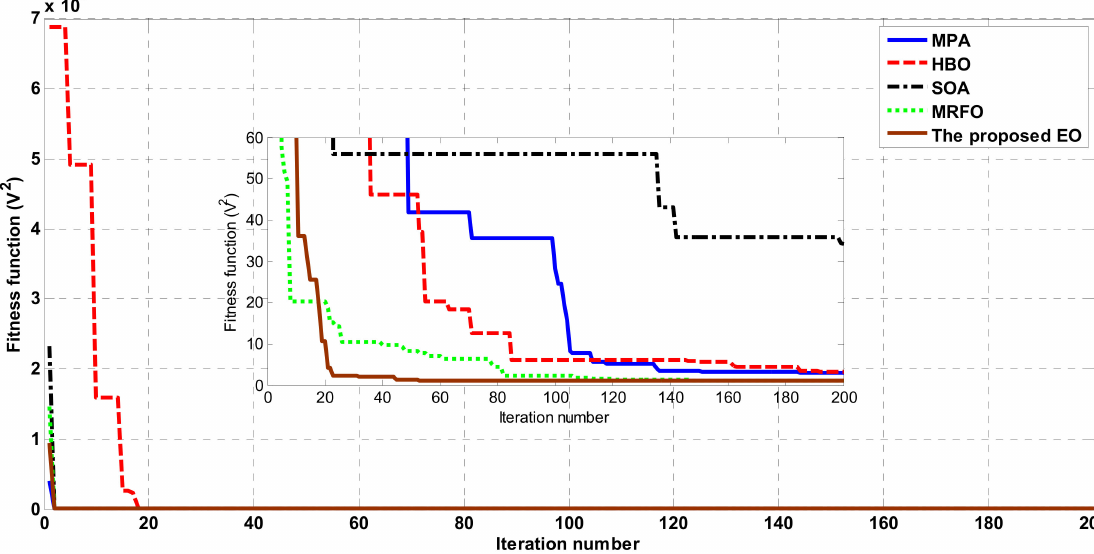
Figure 9. The variation of fitness function during iterative process for all employed optimizers applied for dynamic-state SOFC